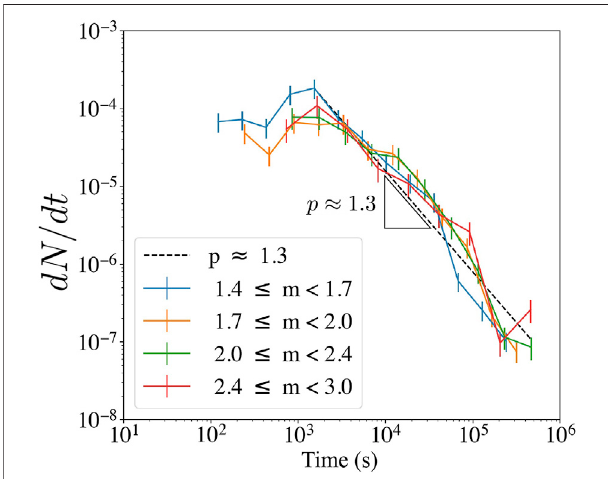
FIGURE 7 | Average triggering or aftershock rates above m c of mainshocks within different magnitude ranges for KSMMA catalog. The black dashed line represents the Omori exponent ( p ≈ 1.3).